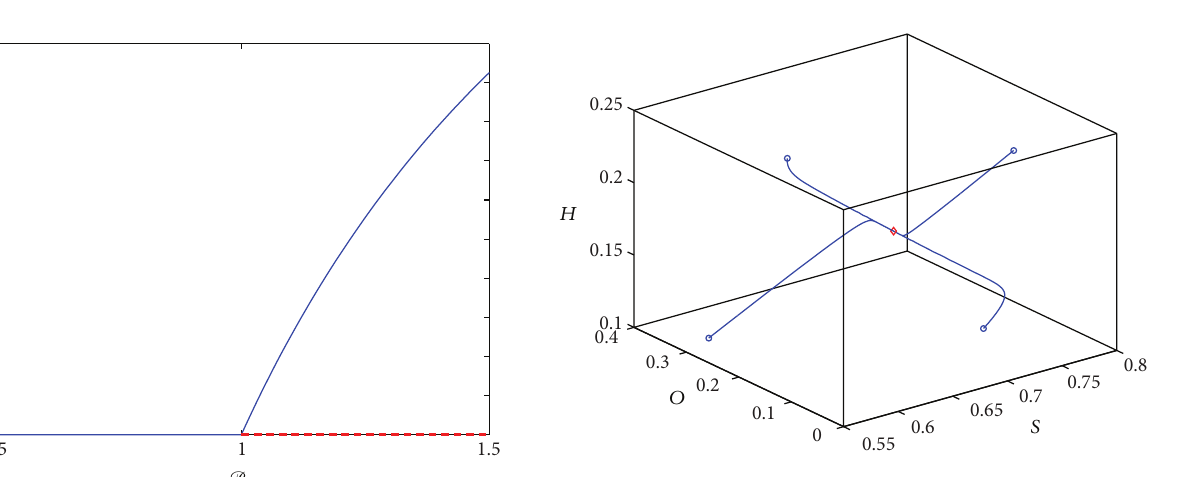
Figure 2: The phase portrait for the endemic equilibrium of system (1). For different initial points ( ∙ ), the solution trajectory approaches the endemic equilibrium ( Q ) with the passage of